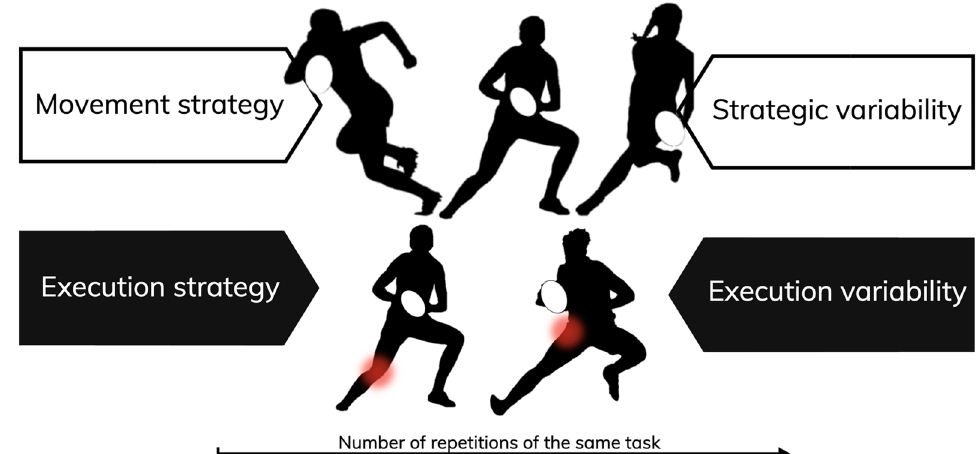
Fig. 1 Overview of key definitions based on Cowin et al. [25]. Movement strategy: The kinematically or kinetically distinct and classifiable motor solution used during the execution of the task. For example, kinematically or visually defined movement strategies may be categorized as a crossover cut or sidestep. In contrast, kinetically defined movement strategies may be described categorically as “knee‑dominant” or “hip‑dominant” as indicated by the red circles. Further, some movement strategies may be defined by clustering a combination of kinematic and kinetic variables depending on the author’s or practitioner’s definitions. Strategic variability: “Describes the different approaches or methods of movement used to complete a task.” Strategic variability is discussed and described over multiple efforts or trials of the same task or how many different movement strategies are used to complete the same task. Movement execution: The magnitude and distribution of joint kinetics or kinematics of a performed trial or effort within a movement strategy. Execution variability: “Describes the intentional and unintentional adjustments of the body between repetitions within the same